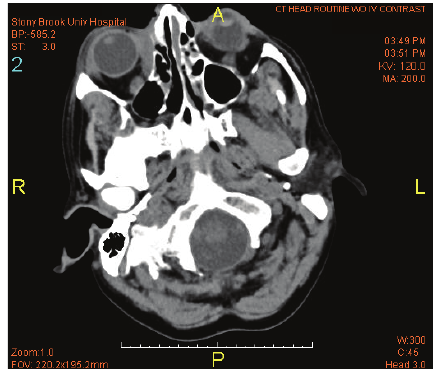
Figure 2: Head CT without contrast. After two cycles of R-CHOP therapy, interval CT scan revealed a significant decrease in size of right intraorbital mass lesion medially with small residual mostly in the medial extraconal